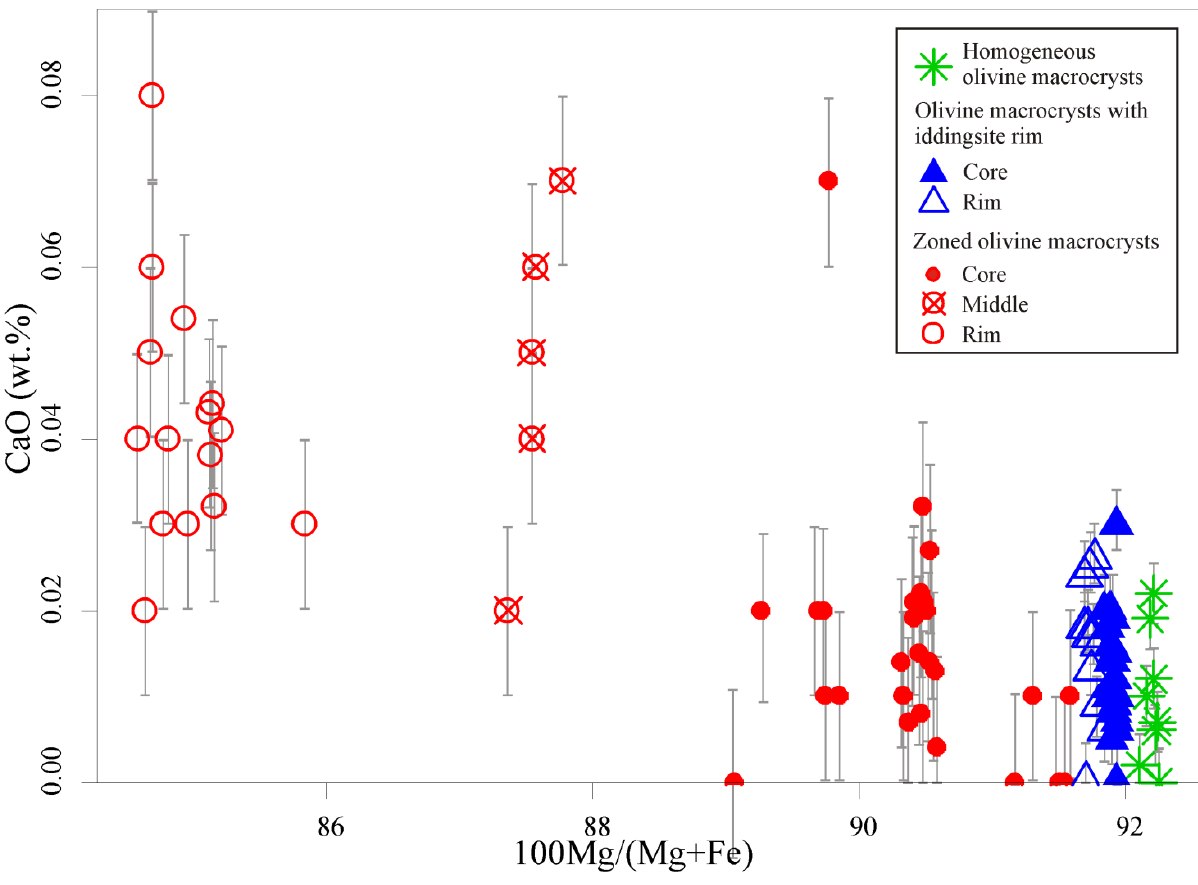
Figure 2. CaO vs. Mg# diagram for olivine macrocrysts from the CA kimberlite. Error bars indicate standard deviation of CaO (wt